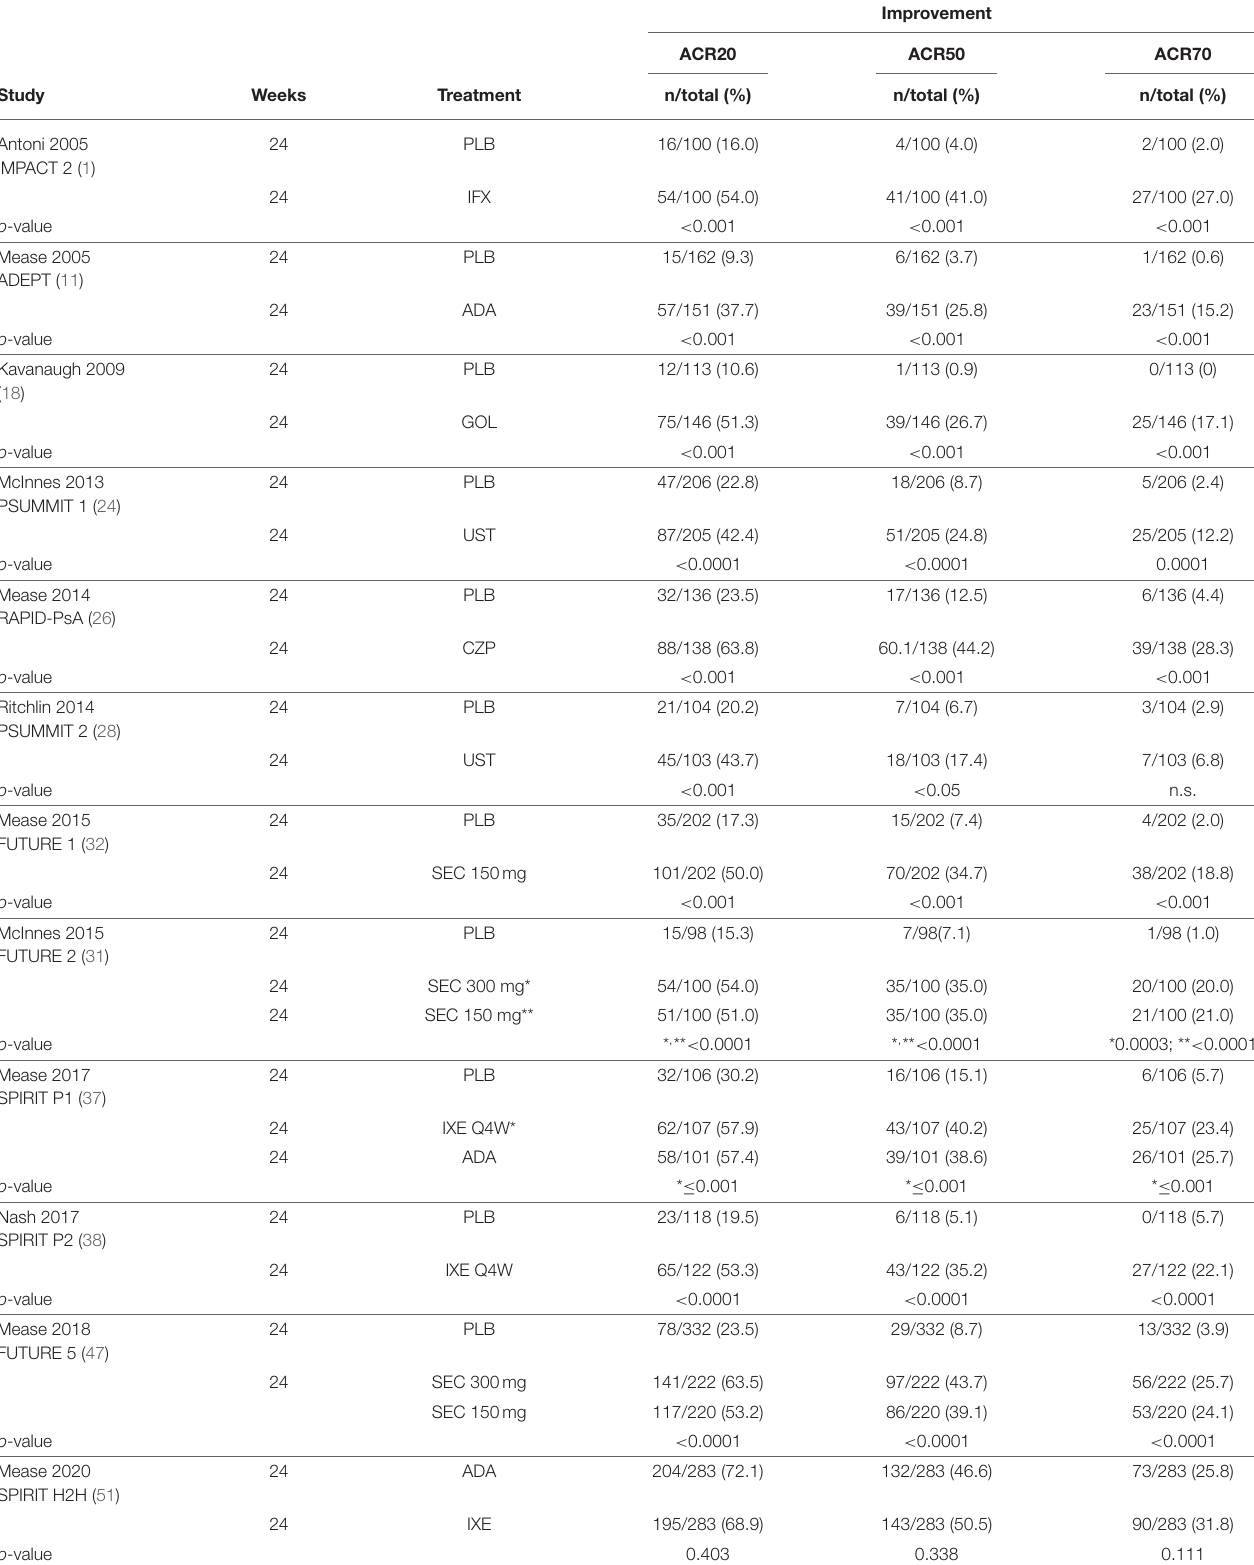
TABLE 3 | ACR improvements in patients with psoriatic arthritis—peripheral